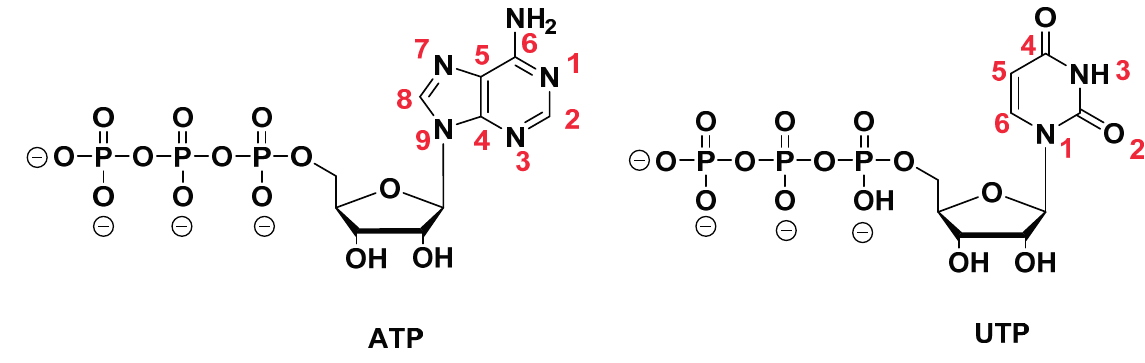
Figure 3. Chemical structure and numbering of the purine and pyrimidine nucleobases exemplified for ATP and